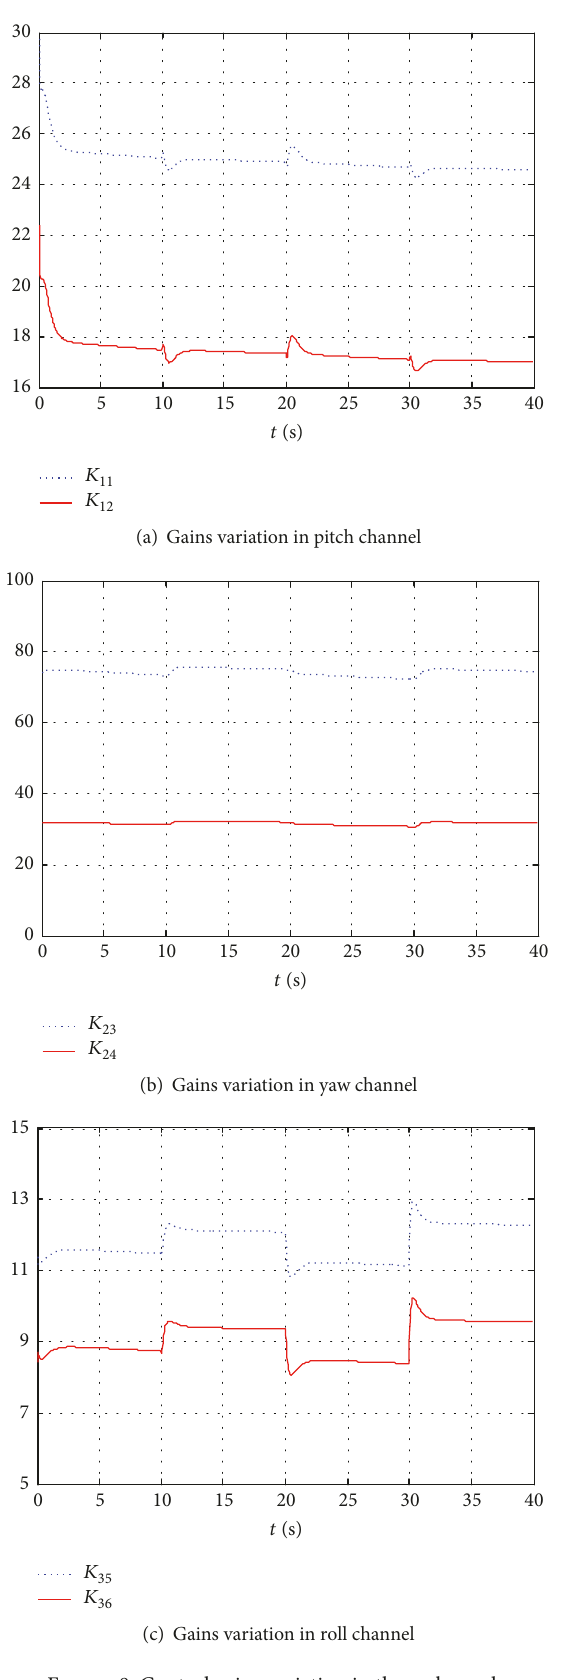
Figure 8: Control gains variation in three